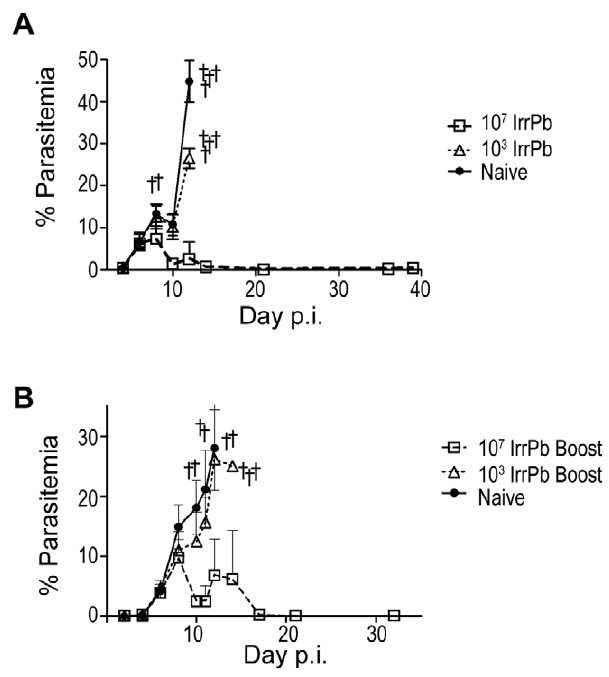
Figure 2. Protection from parasitemia and severe disease in CD1 mice after immunization with irradiated blood-stage Pb-A . A ) Protection in CD1 mice after a single immunization with 10 7 irradiation attenuated Pb-A blood-stage parasites (IrrPb). 10 3 or 10 7 IrrPb were injected iv into groups mice. On day 24 after injection, immunized and naı¨ve mice were challenged with 10 4 virulent Pb-A pRBC and parasitemia was monitored by blood smear (mean + / 2 SD) Daggers indicate mice that were euthanized or that died during the experiment. All naı¨ve mice (4/4, filled circles) and 10 3 IrrPb immunized mice (5/5, open triangles) displayed uncontrolled parasite growth and succumbed to acute blood-stage infection by day 12 after challenge. In contrast, mice immunized with 10 7 IrrPb (4/5, open squares) controlled parasite growth after challenge and managed blood parasitemia down to low or undetectable levels. B ) Protection in CD1 mice after a two immunizations with 10 7 IrrPb. Groups of mice were immunized with 10 3 or 10 7 IrrPb, and then given a boost immunization 24 days later with an equal number of IrrPb (Boost). 24 days after the final immunization, immunized and naı¨ve mice were challenged with 10 4 virulent Pb-A pRBC. In mice immunized with 2 doses of 10 3 IrrPb (n=5 mice, open triangles), parasitemia levels continued to increase after challenge, similar to naı¨ve mice (n=5 mice, filled circles). In contrast, when mice were immunized with 2 doses of 10 7 IrrPb (n=5 mice, open squares), blood parasitemia declined over time to low or undetectable levels.